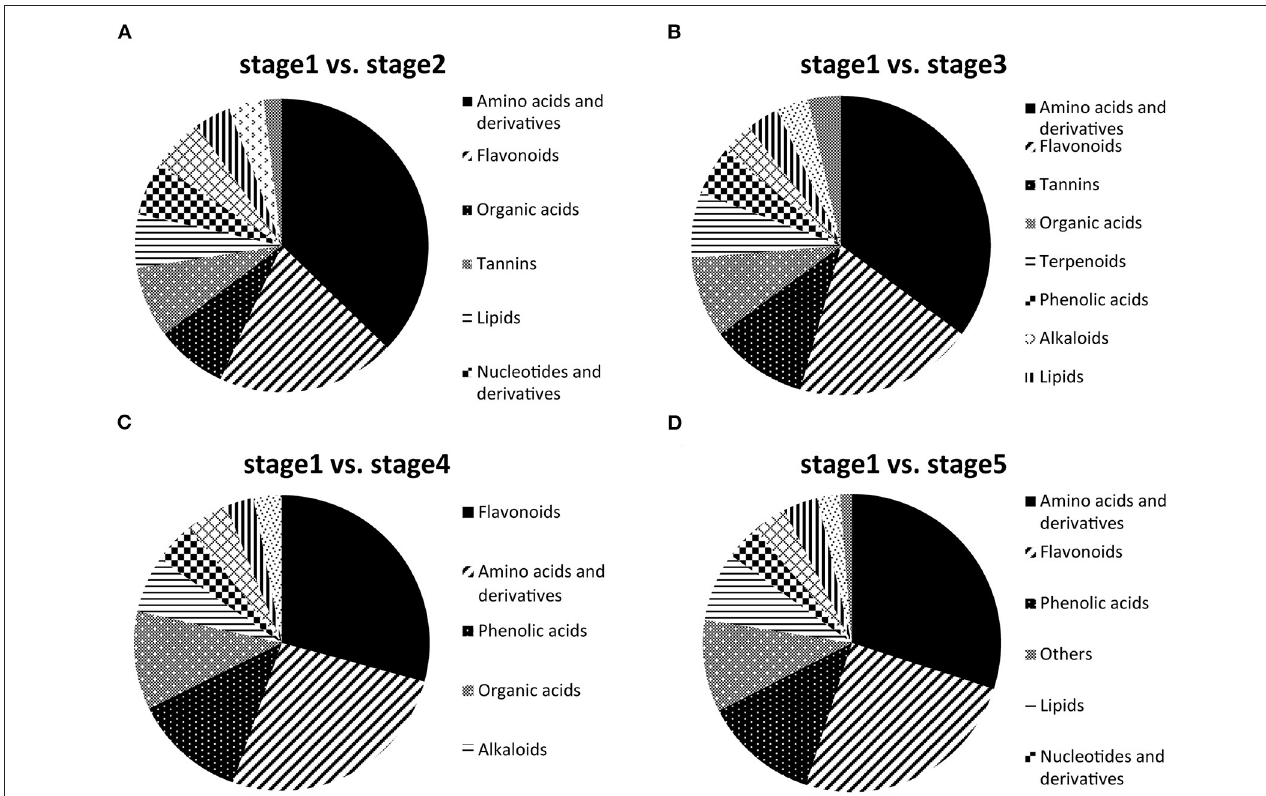
FIGURE 3 | Differentially accumulated metabolites (DAMs) between stage 1 and the other stages (2–5). (A) Component analysis of DAMs in stage 1 vs. stage 2. (B) Component analysis of DAMs in stage 1 vs. stage 3. (C) Component analysis of DAMs in stage 1 vs. stage 4. (D) Component analysis of DAMs in stage 1 vs. stage 5.